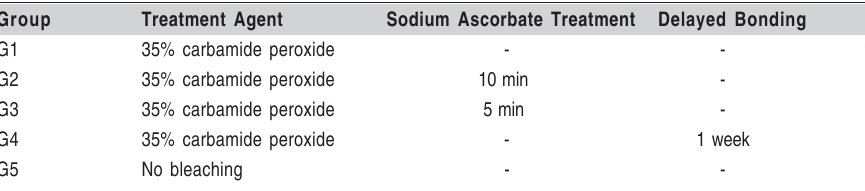
Table 1: Groups, treatment agent used in the